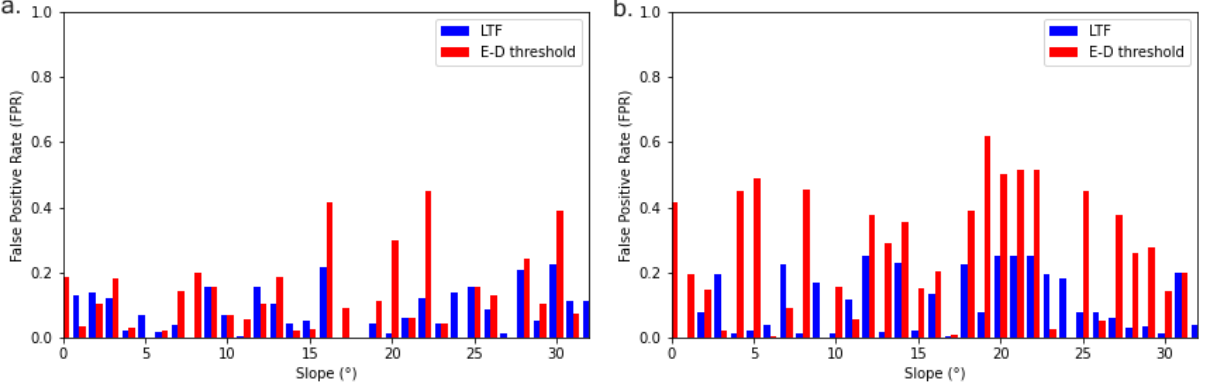
Figure 8. ( a ) E-D and LTF threshold values with corresponding false positive rate for the training dataset (65%) and ( b ) for the testing dataset (35%).